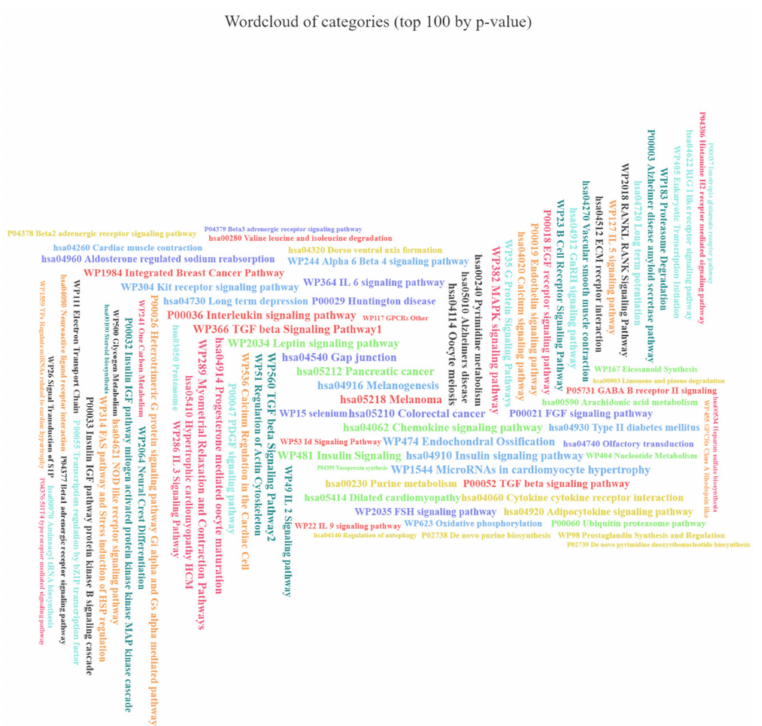
Figure A8. Results of enrichment analysis by miEAA for signaling pathways (miRWalk) generated for 11 significantly upregulated miRNAs shared among T2DM and IFG female subjects while compared to NG female subjects. WP (wikipathways), P (Panther Classification system), hsa (KEGG